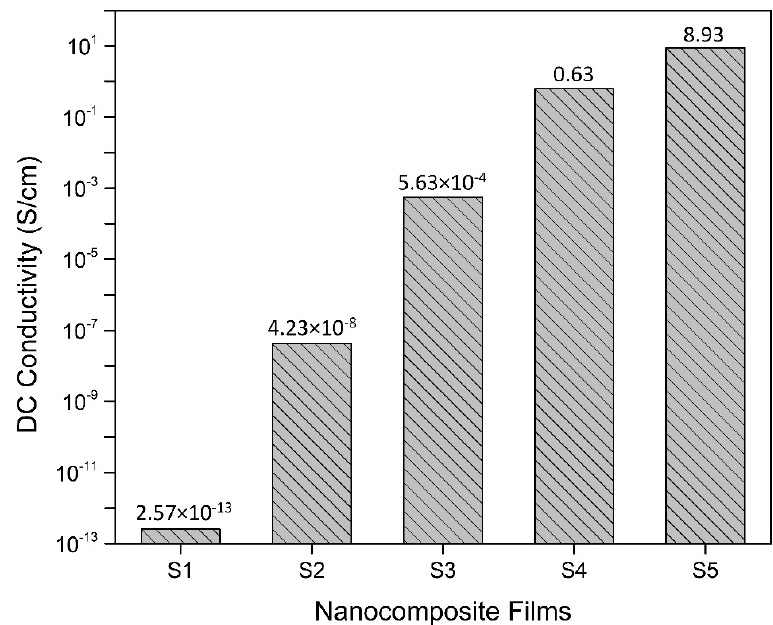
Figure 6. DC conductivity values of prepared nanocomposite films.